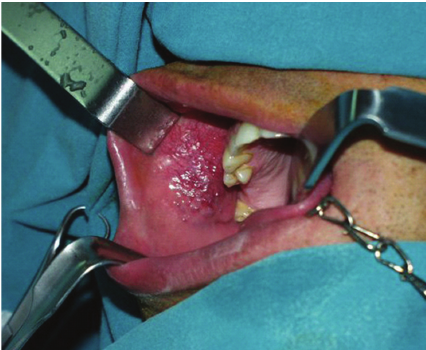
Figure 1: Buccal mucosa BFH: Preoperative view of the lesion.